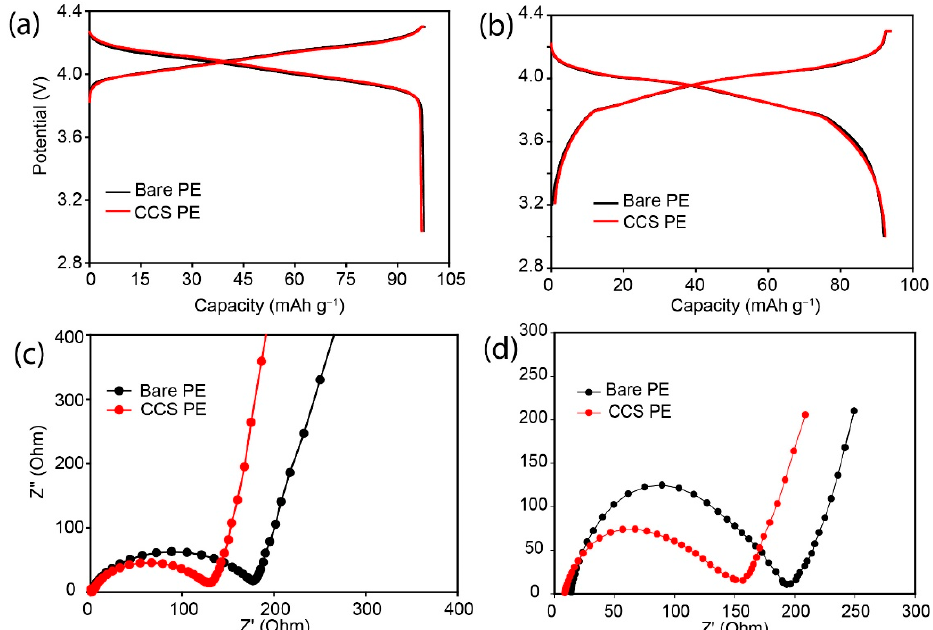
Figure 7. ( a , b ) Voltage profiles of Li/LMO half and Graphite/LMO full cells containing Bare and CCS PE separators respectively. ( c , d ) Nyquist plots for electrochemical impedance analysis of the cells after precycling.